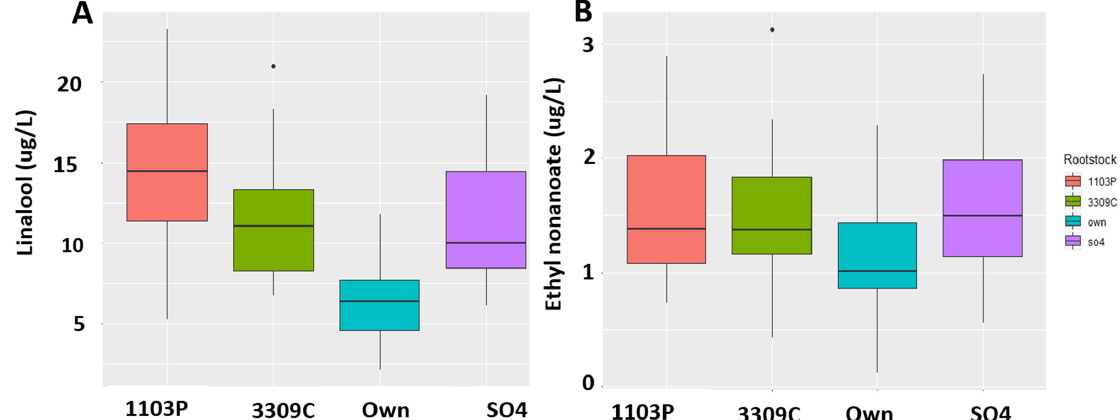
Figure 6. Boxplots of ( A ) β -Linalool (Linalool) and ( B ) Ethyl hexanoate concentrations differences in rootstocks and own- rooted Chambourcin. Rootstocks increased concentrations of Linalool and Ethyl nonanoate in wines 2018. Concentrations were measured in ppb (ug/L).